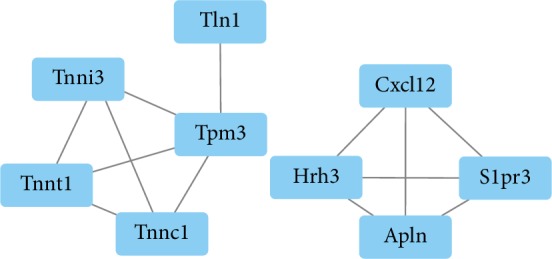
The hub genes were shown in the PPI network.